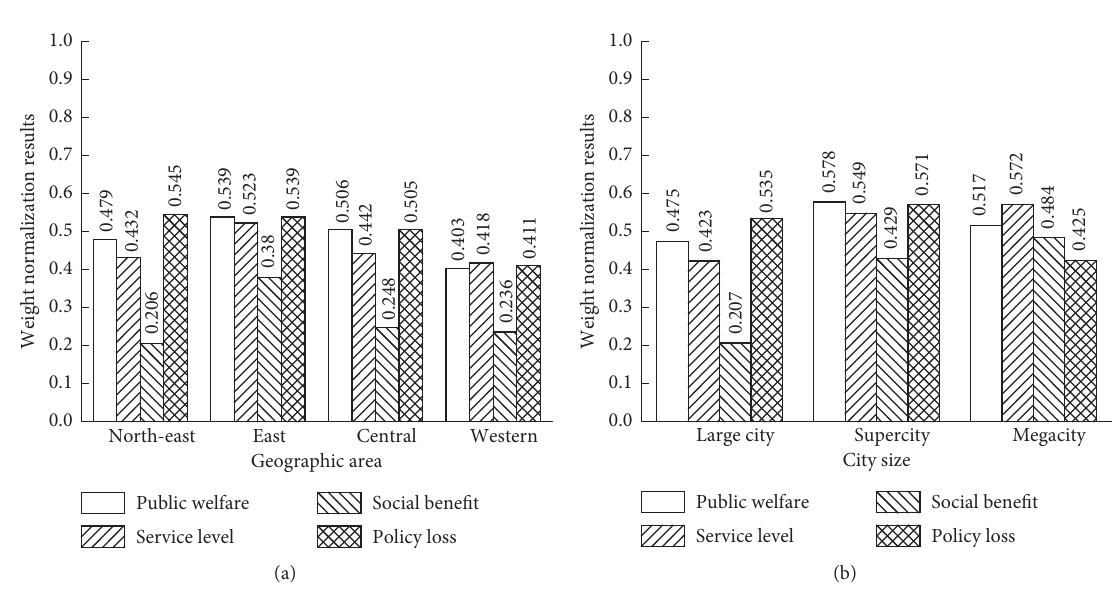
Figure 1: Weight normalization results under different classifications (a) Geographic area (b) City